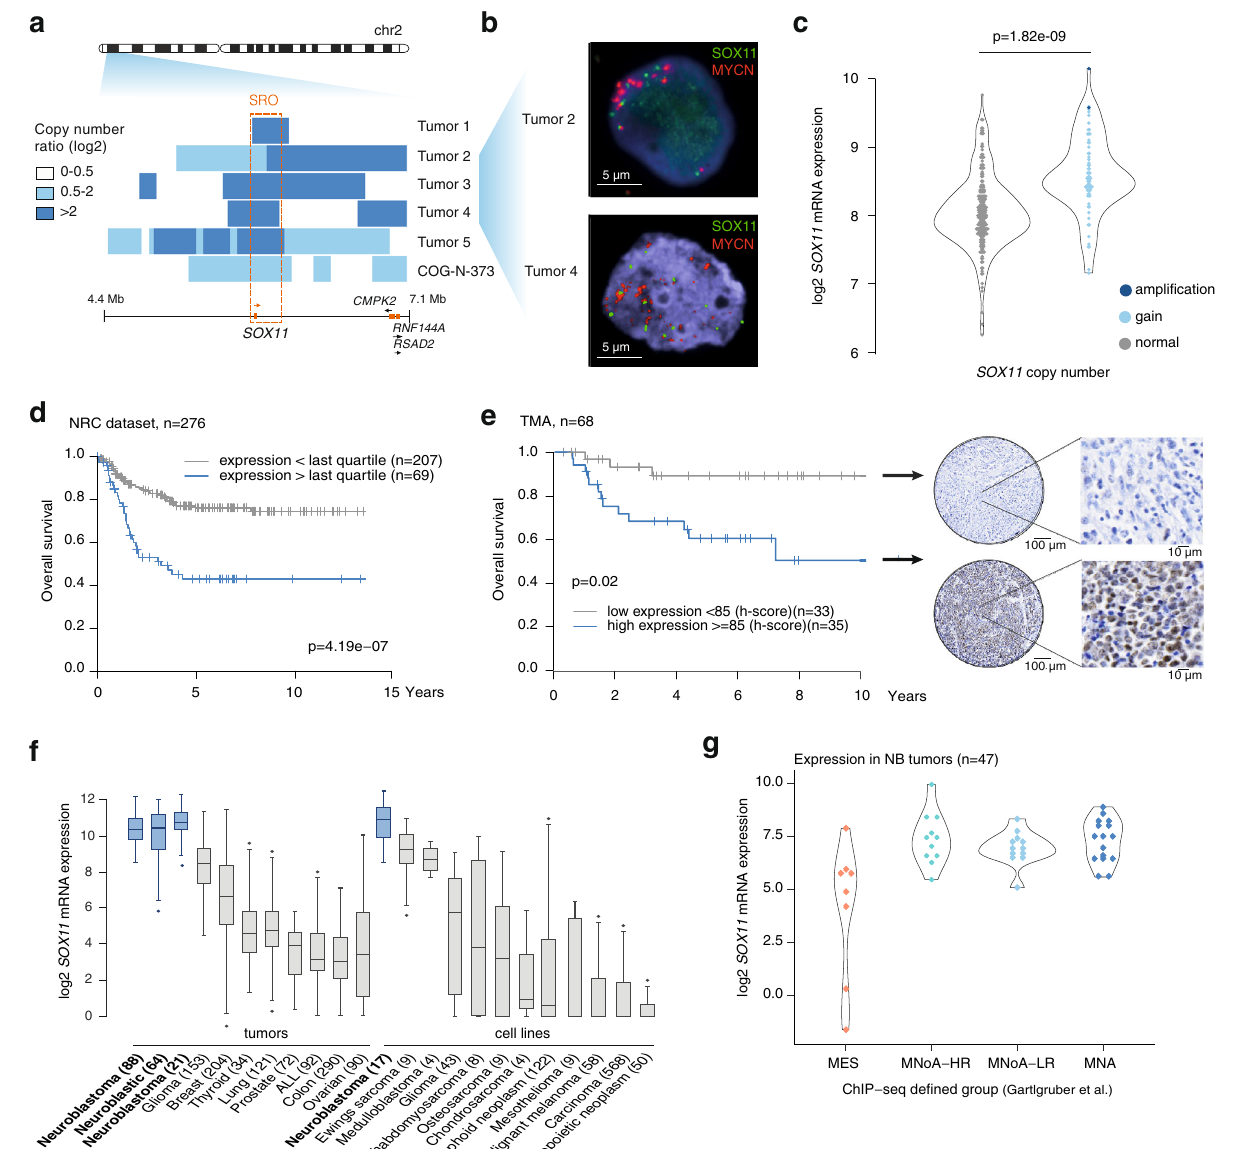
Fig.1|Rarefocalampli fi cationsandlineage-speci fi cexpressionof SOX11 inNB. a Log2 copynumber ratio on chromosome2p(4.4 – 7.1Mb,hg19) showing shortest region of overlap (SRO) (chr2:5,828,671-6,098,736; hg19) for high-level focal 2p gains(log2ratio>0.5)andampli fi cation(log2ratio>2)in5NBtumorsand1NBcell line encompassing the SOX11 locus (GSE103123 10 ). Tumor 1 is evaluated by arrayCGH,tumor5bywholegenomesequencing,andtumor2,3,4andthecellline by shallow whole genome sequencing. b FISH analysis performed on two tumor cases with SOX11 ampli fi cation from Fig. 1a (asterix) showing independent ampli- fi cation of SOX11 (green) and MYCN (red). Scalebar represents 5 µ m. c SOX11 (log2) mRNA levels according to copy number status (ampli fi cation (log2ratio>2), gain (log2ratio>0.3);normal) incohortof 276patients (NRC cohort, GSE85047) 17 (two- tailed T -test, p =1.82e-09).Thesampleswith SOX11 ampli fi cationaretumor4and5 from Fig. 1a. d Kaplan – Meier analysis (overall survival) of 276 neuroblastoma patients (NRC cohort, GSE85047) 17 with high (69) or low (207) SOX11 (log2) expression (highest quartile cut-off) ( p =4.19e-07, Kaplan – Meier). e Immunohistochemical staining for SOX11 on tissue micro-array (TMA) of 68 NB